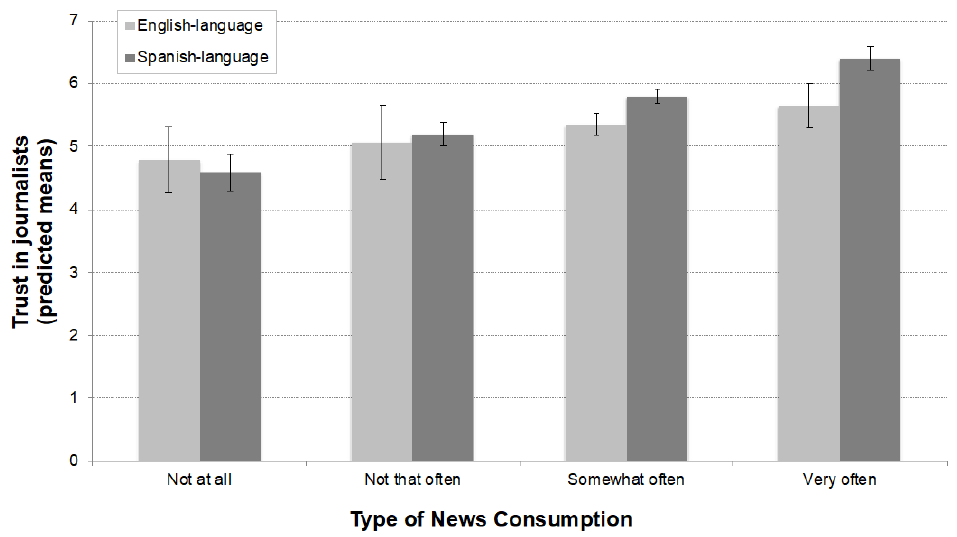
Figure 1. Predicted means of trust by type of news consumption.